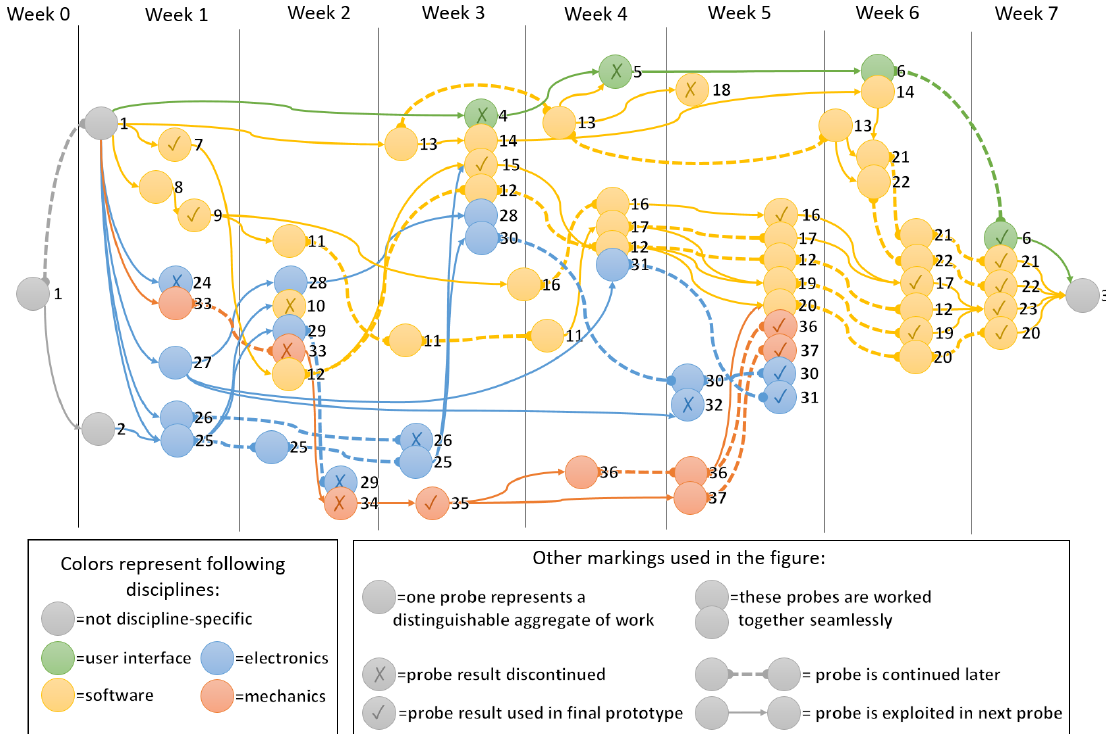
Figure 4. Wayfaring journey depicted with probes.